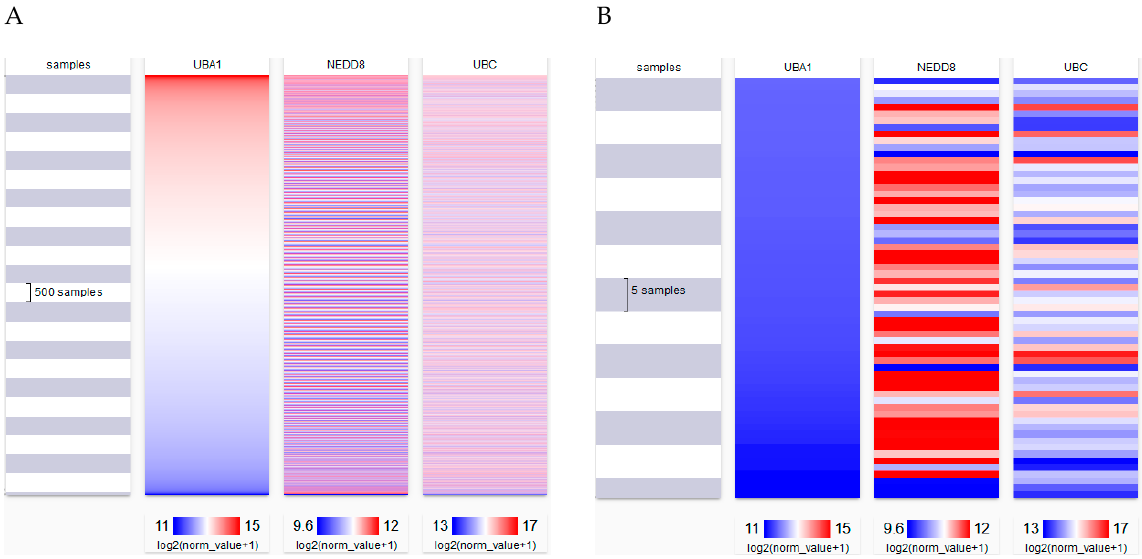
Figure 2. The TCGA Pan-Cancer was used to analyze 11,072 tumor samples for expression levels of UBA1, NEDD8, and UBC. Samples were ranked based upon UBA1 expression and visualized using Xena. ( A ) Visualization of total samples analyzed. ( B ) Visualization of 63 samples with the lowest level of UBA1 expression. Table 1. Comparison of UBA1 and NEDD8 expression in different TCGA samples sets. The regres- sion analysis and statistical significance are noted.